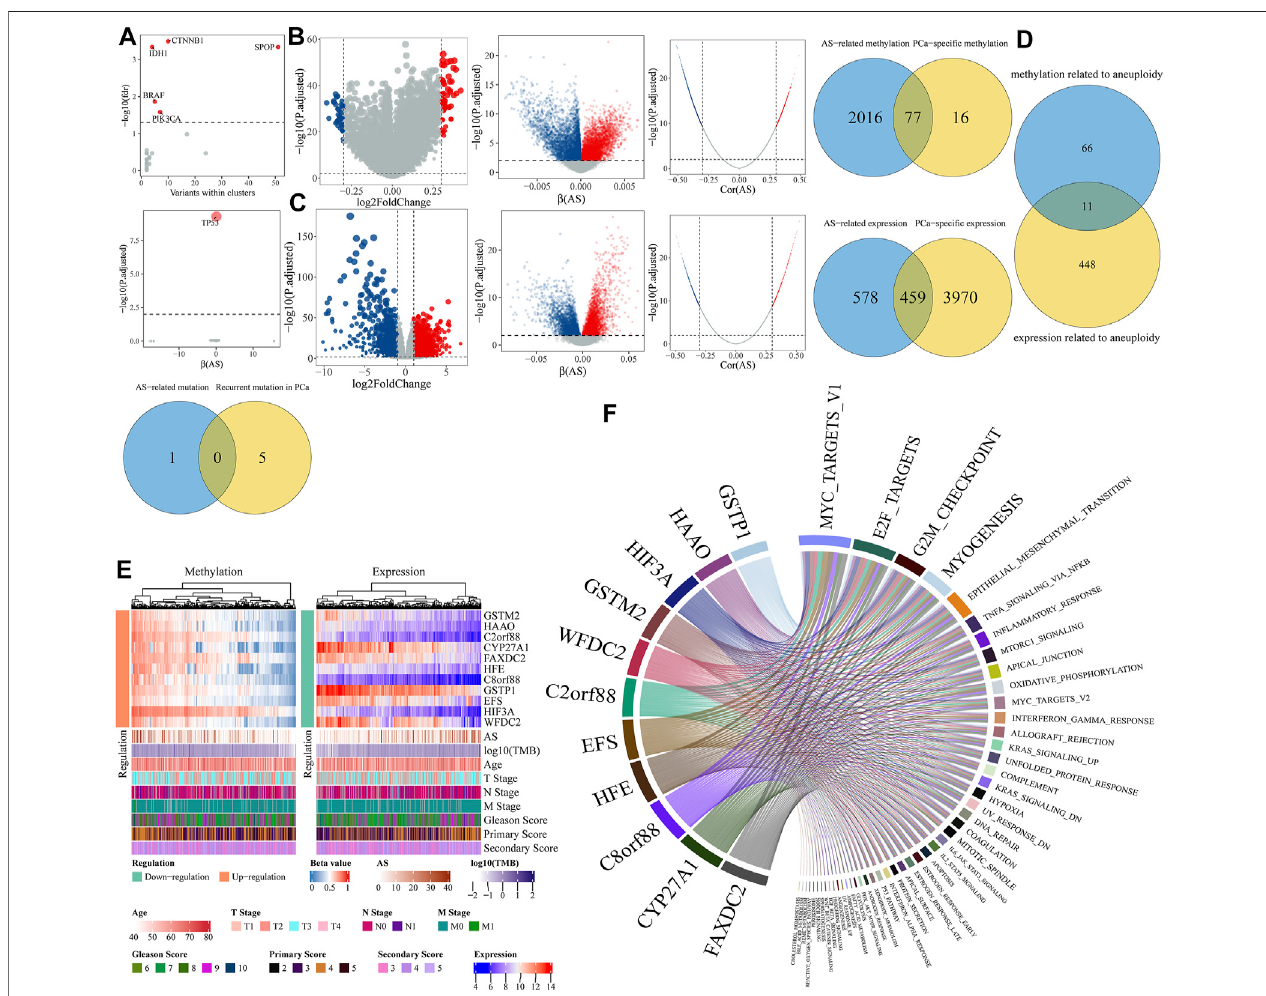
FIGURE5| Identi fi cationofaneuploidydrivergenes. (A) Determinationofrecurrentgenemutationsrelated toaneuploidy.Toppanelrepresentsrecurrentmutation determinedbyOncodriveCLUST.Geneswithadjusted p -value < 0.05werelabeledinred.Middlerepresentslogisticregressionresultswhere x -axismeanscoef fi cient( β ) of aneuploidy and y -axis stands for adjusted p -value whose null hypothesis is β (cid:1) 0. Below panel is a Venn diagram by intersecting above two gene sets. (B,C) Determination of PCa-speci fi c genes related to aneuploidy in (B) methylation pro fi le or (C) gene expression pro fi le. From left to right, fi rst panel is a volcano representingPCa-speci fi cgenesbydifferentialanalysis;secondpanelrepresentslinearregressionresultswhere x -axismeanscoef fi cients( β )ofASand y -axisstandsfor adjusted p -value whose null hypothesis is β (cid:1) 0. Red means upregulation, blue means downregulation, and gray means insigni fi cant. Third panel, where x -axis means correlation coef fi cients (Cor) of AS and y -axis stands for adjusted p -value, represents Spearman correlation analysis results. Red point means positive correlation, blue means negative correlation, and gray means noncorrelation. Genes were regarded as AS-related genes of both |Cor| > 0.3 and adjusted p -value < 0.01 in Spearman correlation analysis and adjusted p -value < 0.01 in linear regression. Fourth panel is a Venn diagram by overlapping AS-related genes with PCa-speci fi c genes. (D) Determination of aneuploidy driver genes regulated by anomalous methylation. (E) Heatmap of methylation and expression levels of driver genes. (F) Chord diagram illustrates relationships determined by GSEA between driver genes and hallmark